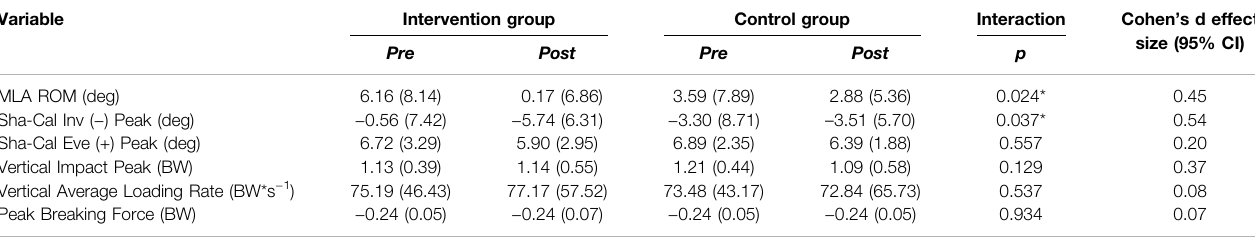
TABLE 3 | Mean (standard deviation) pre- and post-intervention values for kinetic and kinematic biomechanical measures in the experimental groups. p -values of the interaction effect (group × time) and Cohen ’ s d effect sizes are presented.